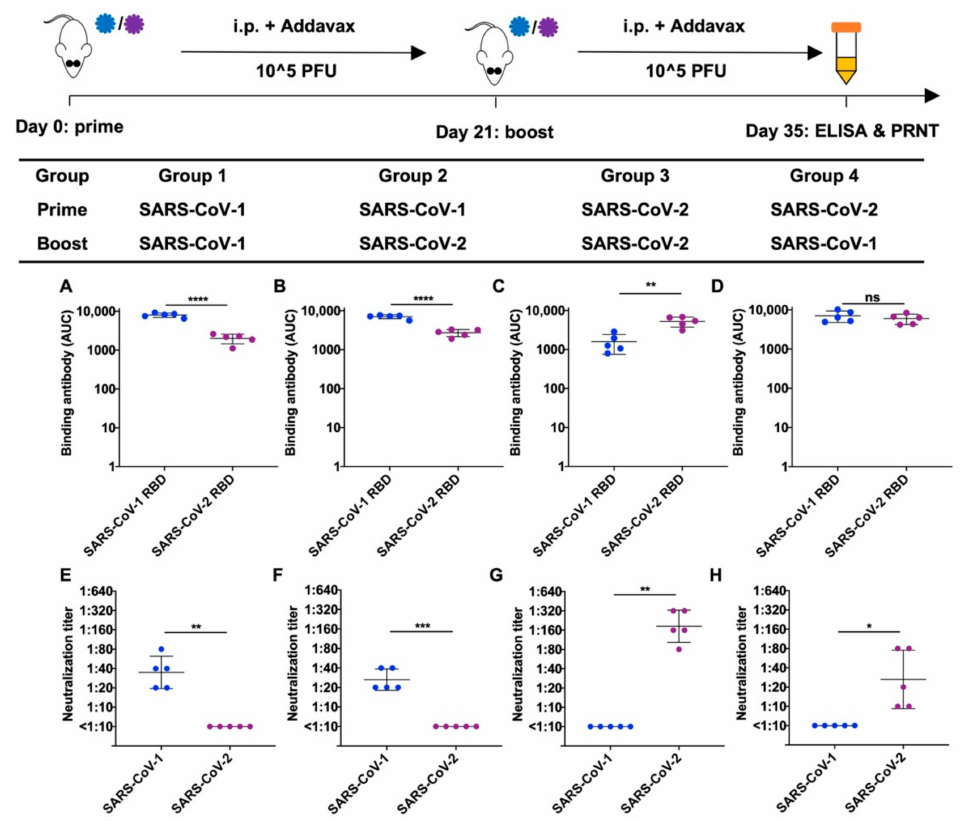
Figure 1. Binding and neutralization of mouse plasma 14 days after homologous or heterologous immunization of SARS-CoV-1 and SARS-CoV-2. Plasma samples were collected 14 days (day 35) after two rounds of immunization (prime-day 0, boost-day 21) with SARS-CoV-1 or SARS-CoV-2 as illustrated. ( A – D ) RBD (receptor binding domain) proteins from SARS-CoV-1 and SARS-CoV-2 were used as the antigen coating on the ELISA plates. Binding of RBD to serial diluted plasma sample was analyzed from five mice immunized using ( A ) SARS-CoV-1 homologous prime-boost, ( B ) het- erologous SARS-CoV-1-prime, SARS-CoV-2-boost, ( C ) SARS-CoV-2 homologous prime-boost, and ( D ) heterologous SARS-CoV-2-prime, SARS-CoV-1-boost. AUC, area under the curve. ( E – H ) Neutral- izing titers (PRNT 90 ) of plasma samples from mice immunized with ( E ) SARS-CoV-1 homologous prime-boost, ( F ) heterologous SARS-CoV-1-prime, SARS-CoV-2-boost, ( G ) SARS-CoV-2 homologous prime-boost, and ( H ) heterologous SARS-CoV-2-prime, SARS-CoV-1-boost, were analyzed by a PRNT (plaque reduction neutralization test) assay. Each data point in the figure represents the mean of two replicates. Error bars represent standard deviation. p -values were calculated using a two-tailed t -test (* p < 0.05, ** p < 0.01, *** p < 0.001, **** p < 0.0001, ns (not